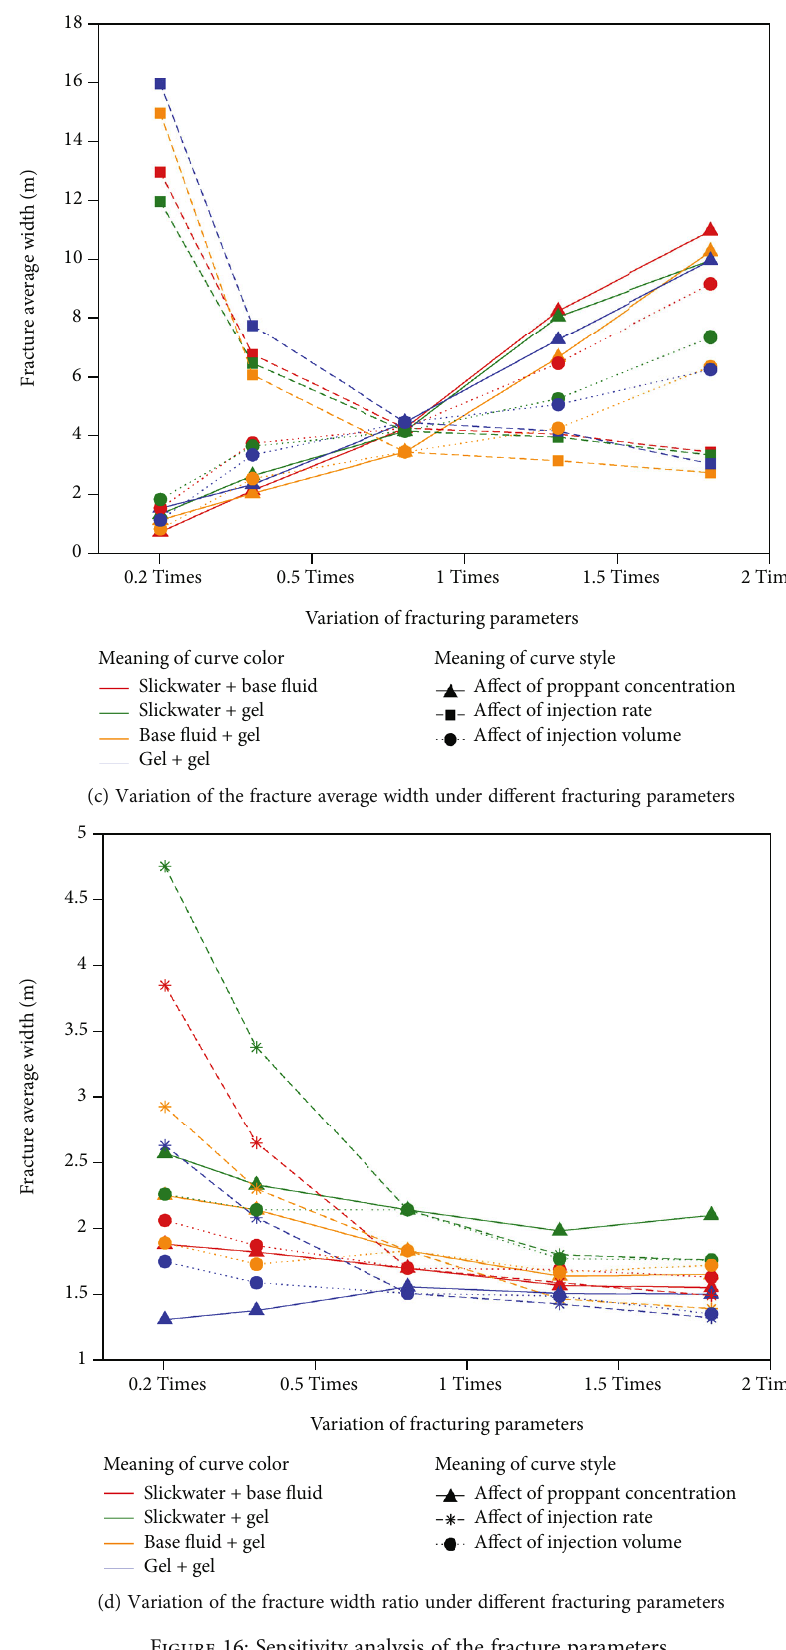
Figure 16: Sensitivity analysis of the fracture